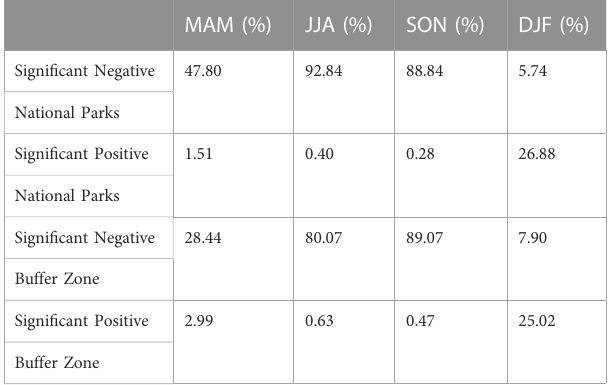
TABLE 4 Percentage of National Parks in the GLTFCA landscape that have signi fi cant negative Directional Persistence or signi fi cant positive Directional Persistence, by season. (MAM, March, April, May; JJA, June, July, August; SON, September, October, November; DJF, December, January, February).